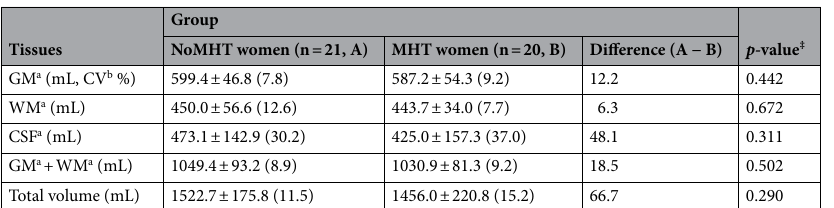
Table 2. Differential intracranial brain volumes in noMHT and MHT women. MHT menopausal hormone therapy, GM gray matter, WM white matter, CSF cerebrospinal fluid. ‡ The difference between noMHT and MHT women was analyzed with independent two sample t -test. a The volume was measured by using ’get_totals.m’ function from segmented individual data on SPM12. b The percentage indicates the coefficient of variation ( CV = [SD/volume mean] ×